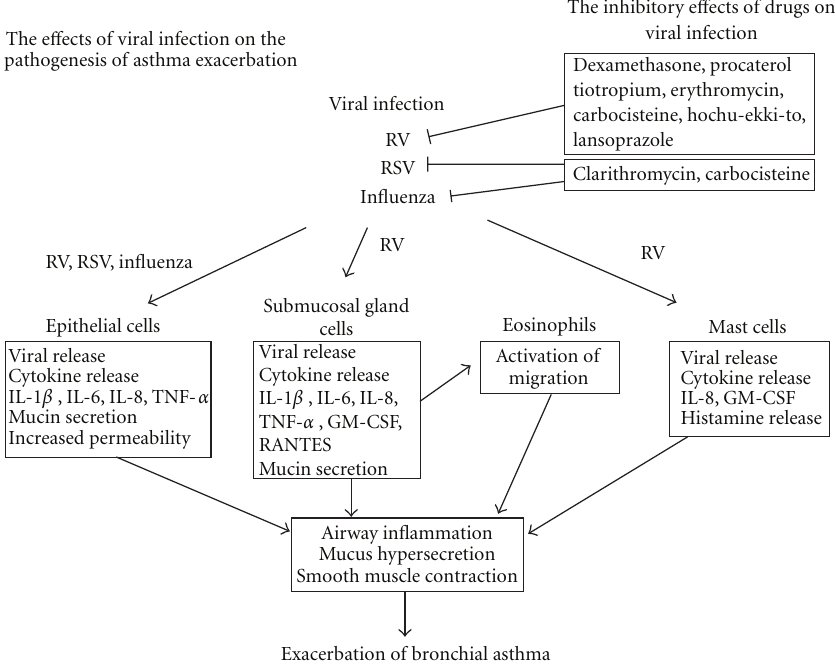
Figure 3: Summary of our findings on the e ff ects of viral infection on the pathogenesis of viral infection-induced asthma exacerbation and on the inhibitory e ff ects of drugs on viral infection. RV: rhinovirus, RSV: respiratory syncytial virus, IL: interleukin, TNF: tumor necrosis factor, GM-CSF: granulocyte-macrophage colony stimulating factor. (Cited from [14, 15, 19, 29, 30, 36–40, 43–46, 49, 53, 55, 56, 61, 72, 77, 80,